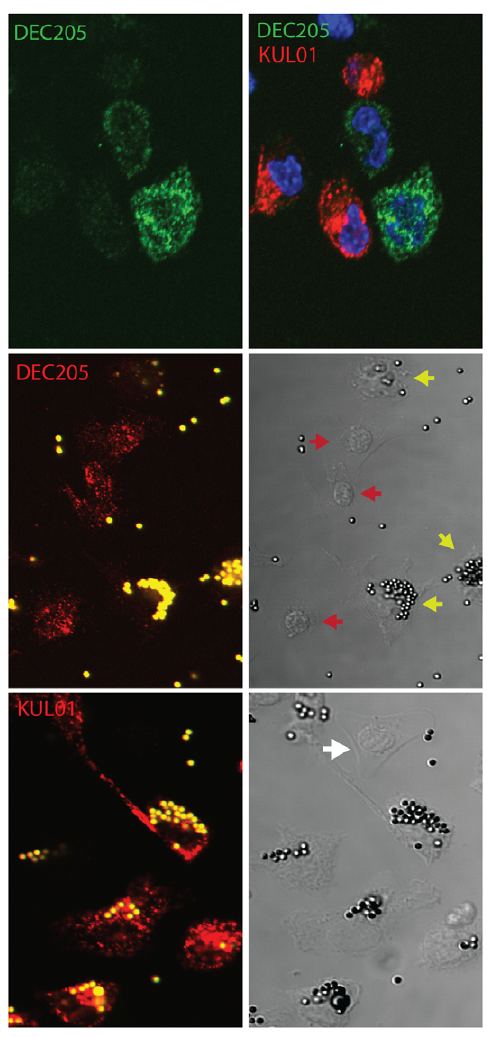
Figure 10. Adherent cells expressing DEC205 are non-pahgo- cytic. The top pair of panels shows confocal images of fresh adherent cells stained with both DEC205 and KUL01 antibodies. The left hand image reveals low level expression of DEC205 on the KUL01 positive cells. The same cell preparation was incubated with fluorescent microbeads for three hours and then fixed and permeablised before staining with either DEC205 antibody FG9 (middle) or KUL01 (bottom), and examination by confocal microscopy. The pseudocoloured fluorescence images are on the left with beads in yellow and antibody staining in red. At the right are the corresponding differential interference contrast images. Red arrows point to cells that are strongly stained with DEC205 antibody but have no internalised fluorescent beads. Yellow arrows point to cells that have internalised fluorescent beads. The white arrow points to a cell that is not stained with KUL01.